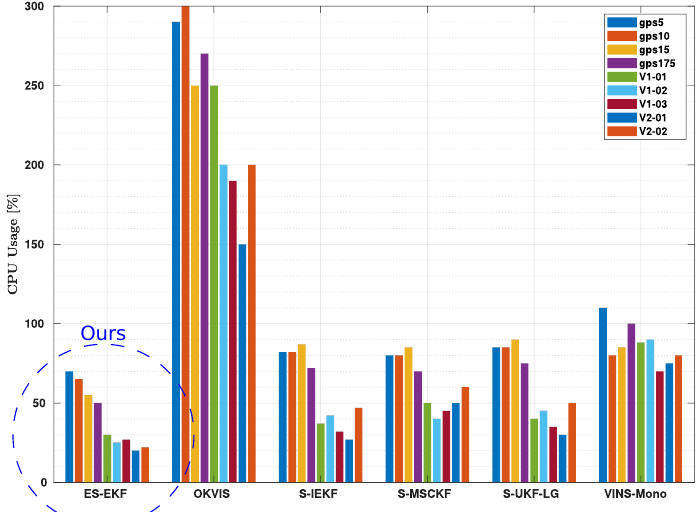
Figure 10. CPU usage as a real-time performance analysis